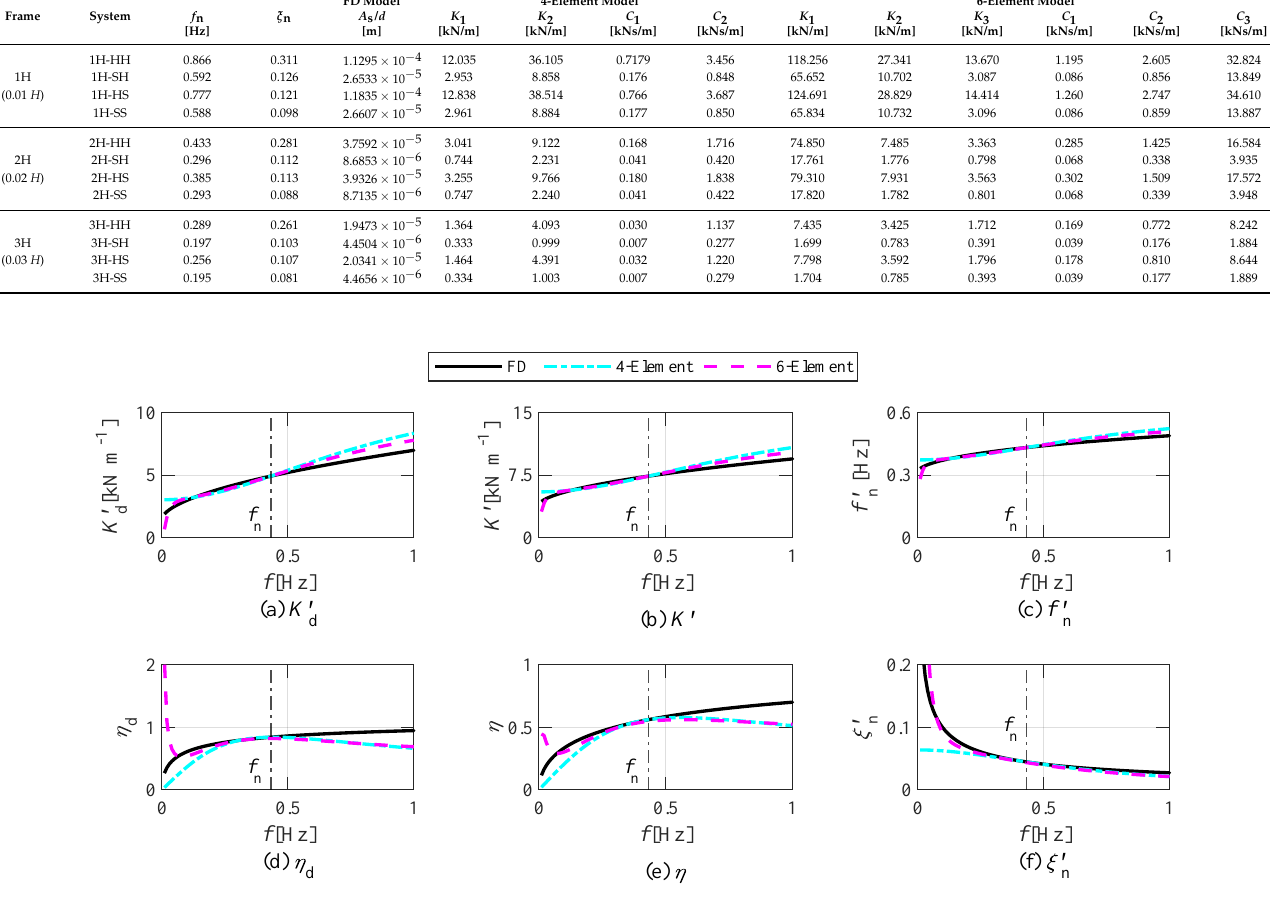
Figure 6. Effectof VE system frequency sensitivity on parameters (2H-HH system).